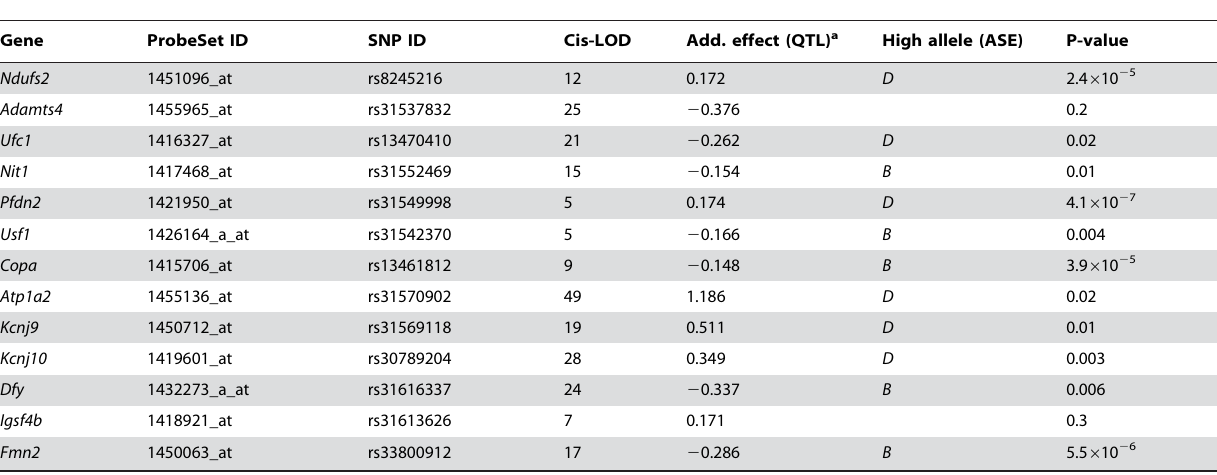
Table 4. Validation of cis -QTLs by measuring allele specific expression difference.